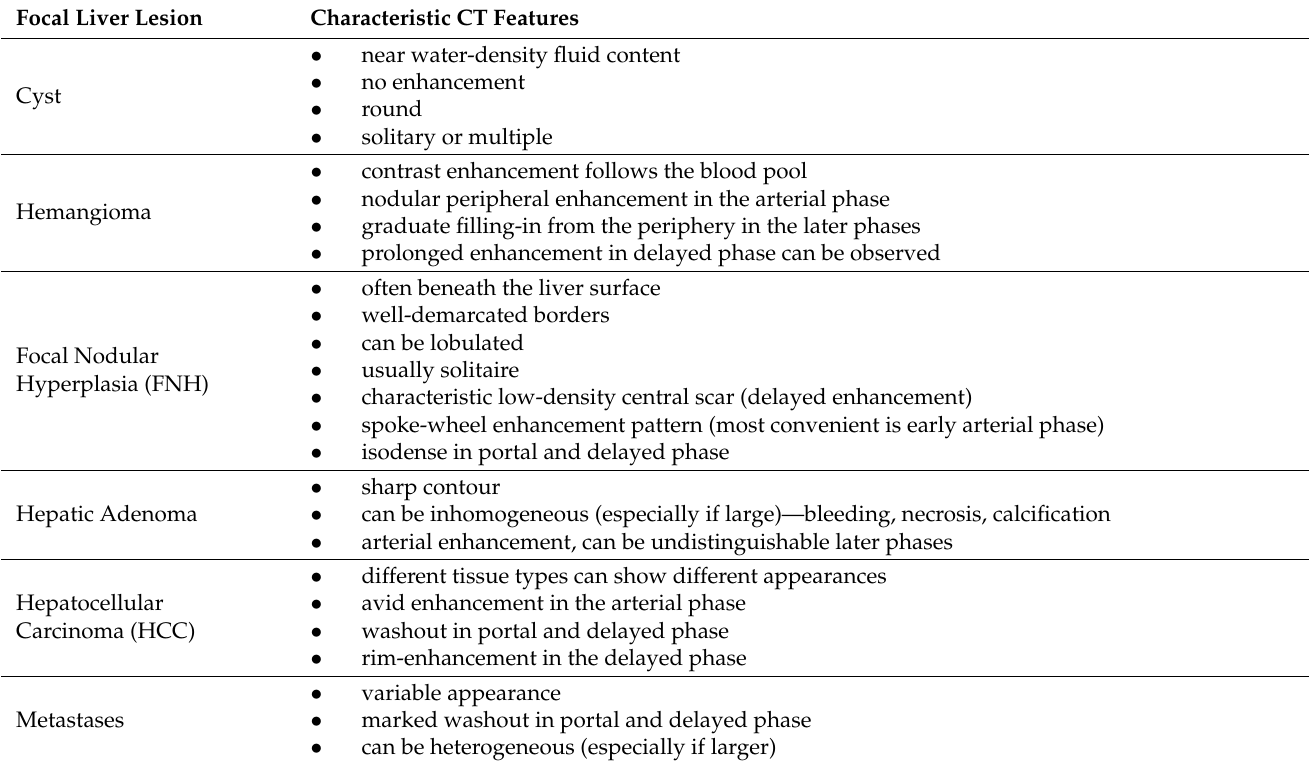
Table 1. The properties of the focal nodular